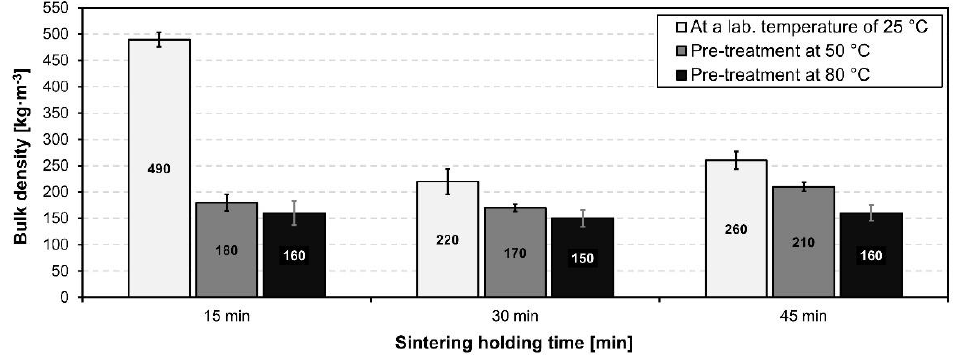
Figure 11. Bulk density of prepared foam samples fired at 850 °C with different sintering holding times of 15, 30 and 45